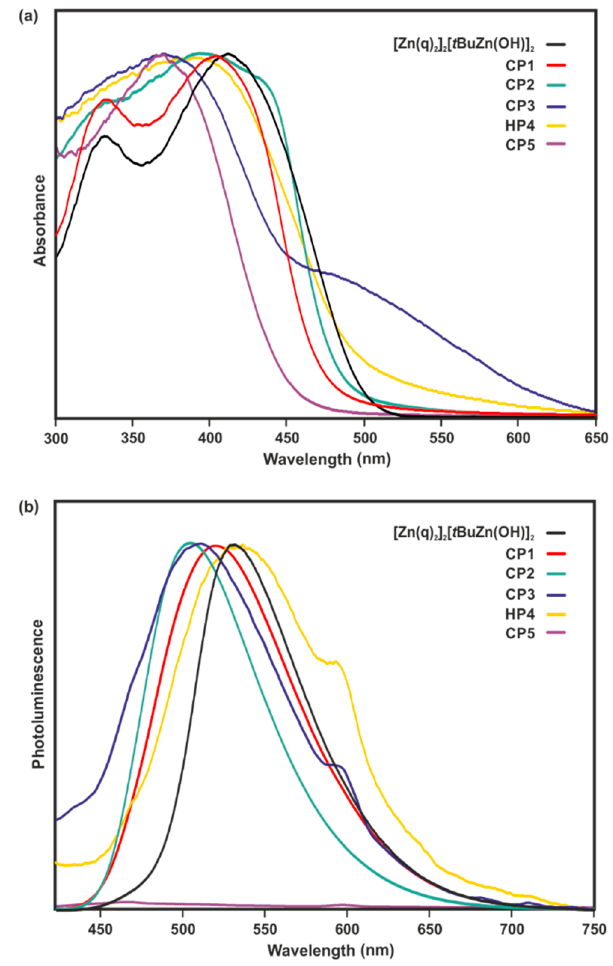
Figure 3. Normalized ( a ) UV-Vis absorption measured in diffusive reflectance of compound powders dispersed with BaSO 4 , ( b ) luminescent spectra measured in the solid-state of the [Zn(q) 2 ] 2 [ t BuZn(OH)] 2 precursor and CP1 – CP5 and HP4 coordination polymers at room temperature; excitation at 400 nm.